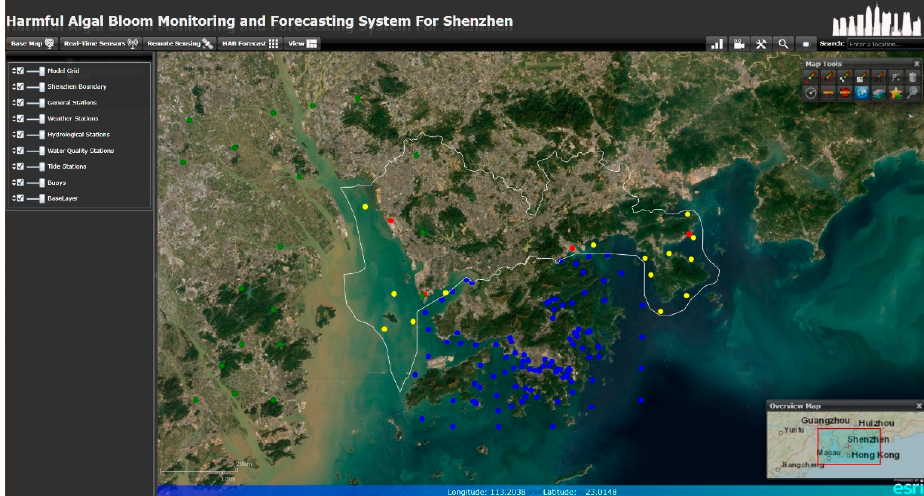
Figure 4. Web-GIS based user interface of the web portal.